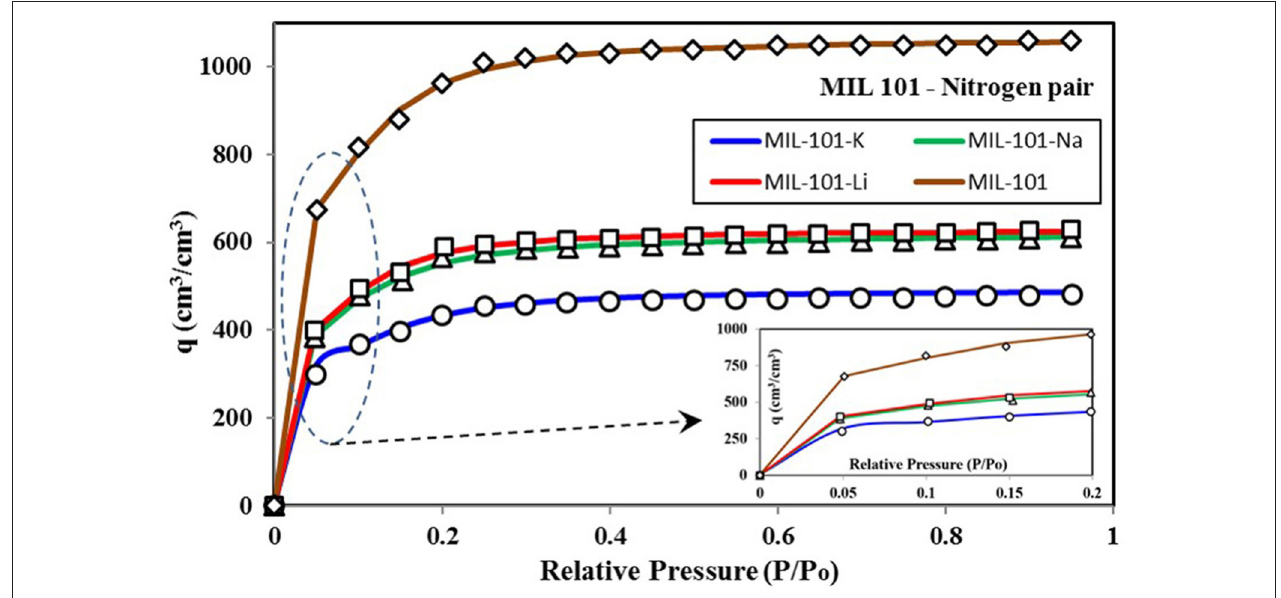
FIGURE 3 | Isotherms for MIL-101 variants paired with nitrogen as the adsorbate. The expanded section shows a small saturation of uptake at lower pressure ratios.